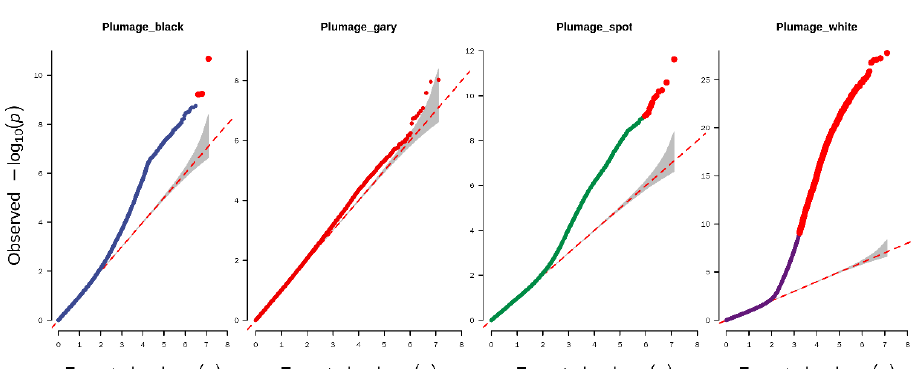
Figure 2. SNP density plot.